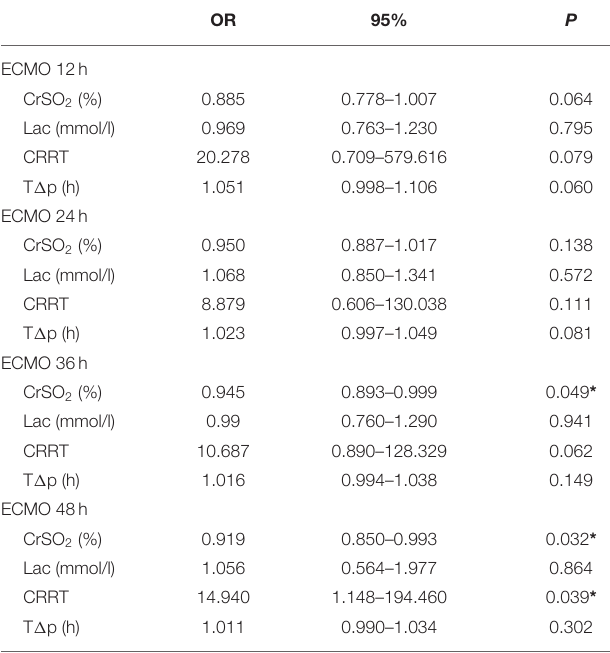
TABLE 4 | Multivariate logistics regression analysis of the hemodynamic monitoring indices during ECMO and their association with mortality. OR